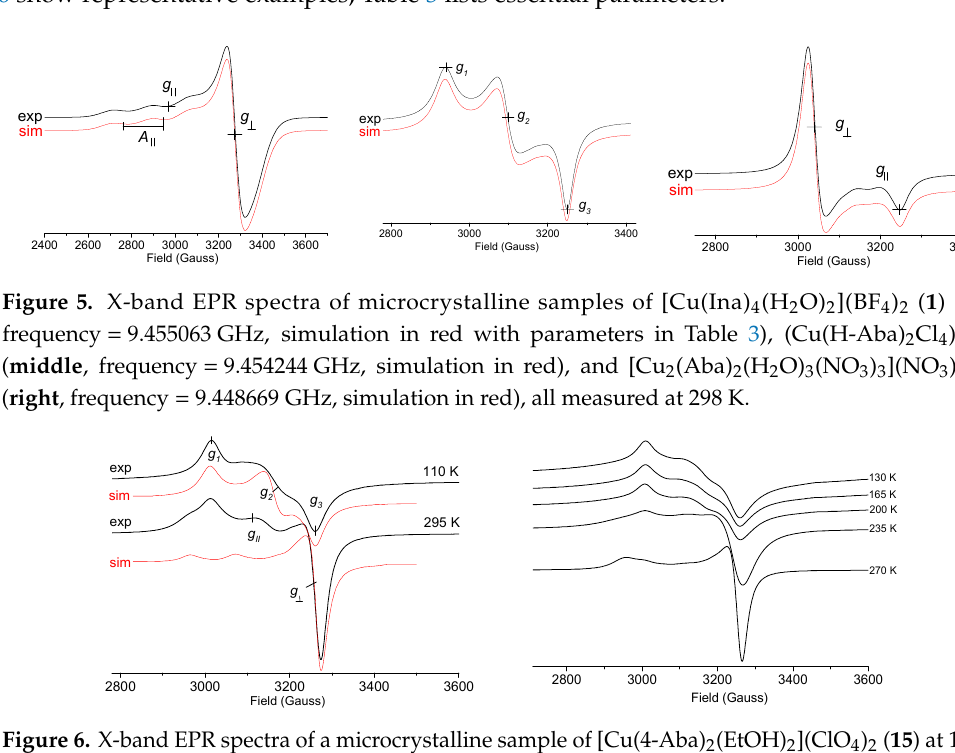
Figure 6. X-band EPR spectra of a microcrystalline sample of [Cu(4-Aba) 2 (EtOH) 2 ](ClO 4 ) 2 ( 15 ) at 110 K (frequency = 9.459916 GHz) and 295 K (frequency = 9.448669 GHz) both with simulations in red (left) and at temperatures ranging from 130 to 270 K (right). Table 3. Selected X-band EPR data of Cu II compounds. a